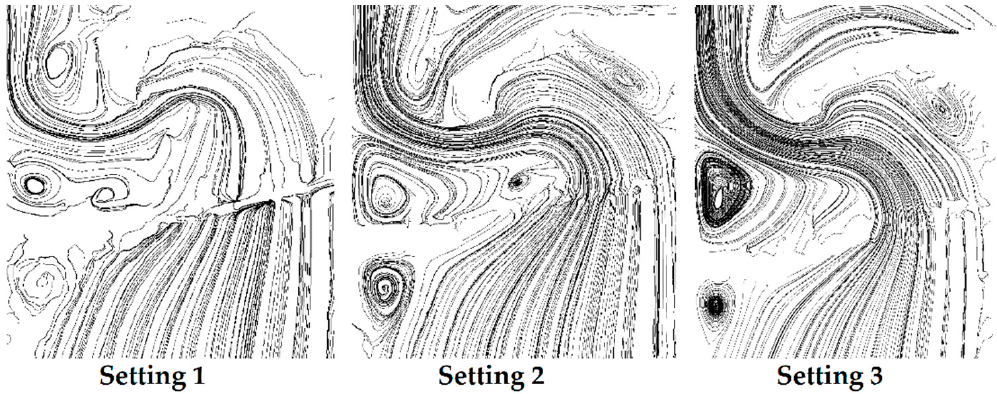
Figure 8. Streamlines from the first measurement area [22].